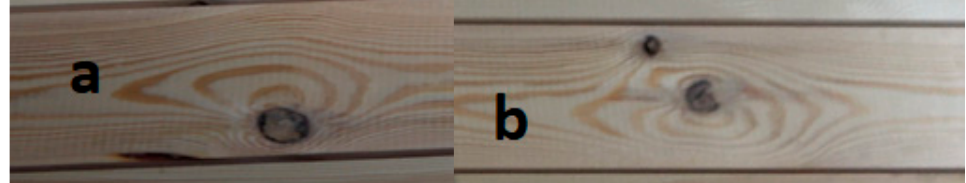
Figure 6. The appearance of critical areas of lumber forming the face of P34 beam—side from lamella 2.